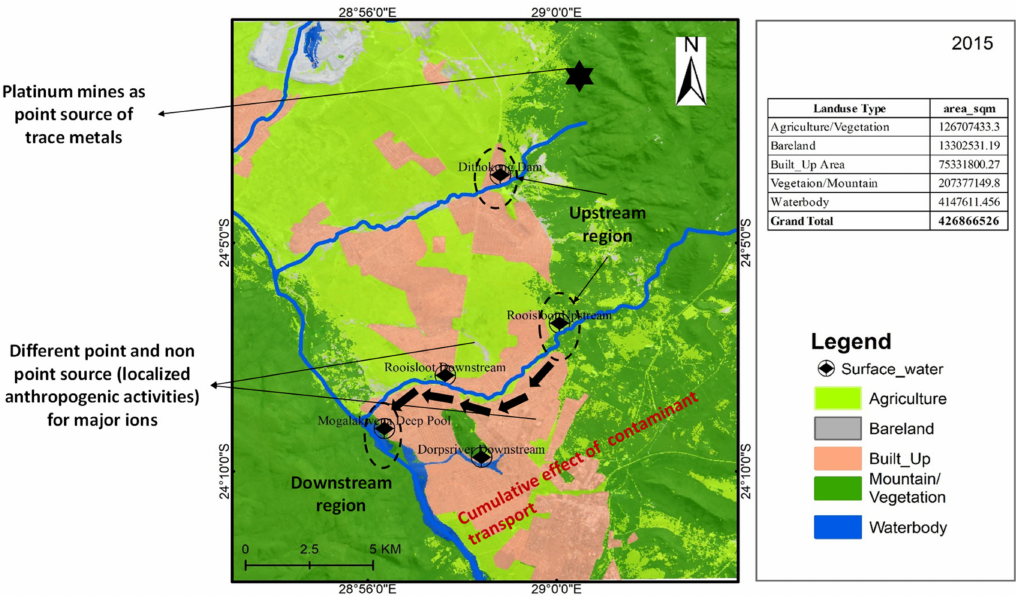
Figure 7. Conceptual diagram showing processes involved in water quality